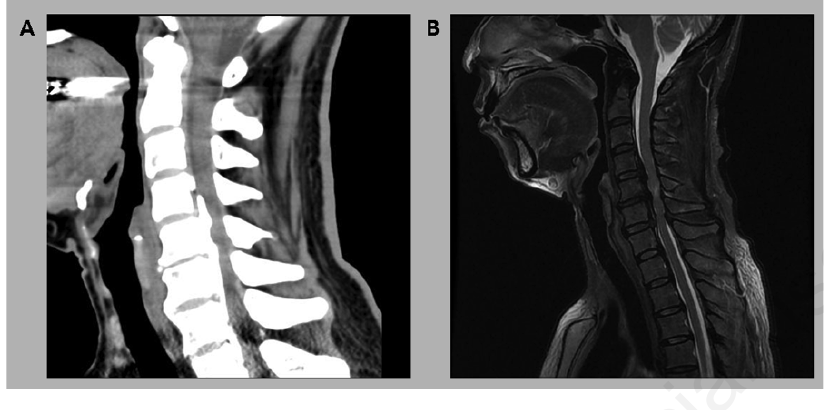
Figure 1. The sagittal CT (A) and T2-weighted cervical spine MRI (B) at 3 months after symptom onset showed ossification of the posterior longitudinal ligament at the level of C3-T1 with cervical cord compression and high signal intensity in the cervical spinal cord at the C5-6 disc space level.